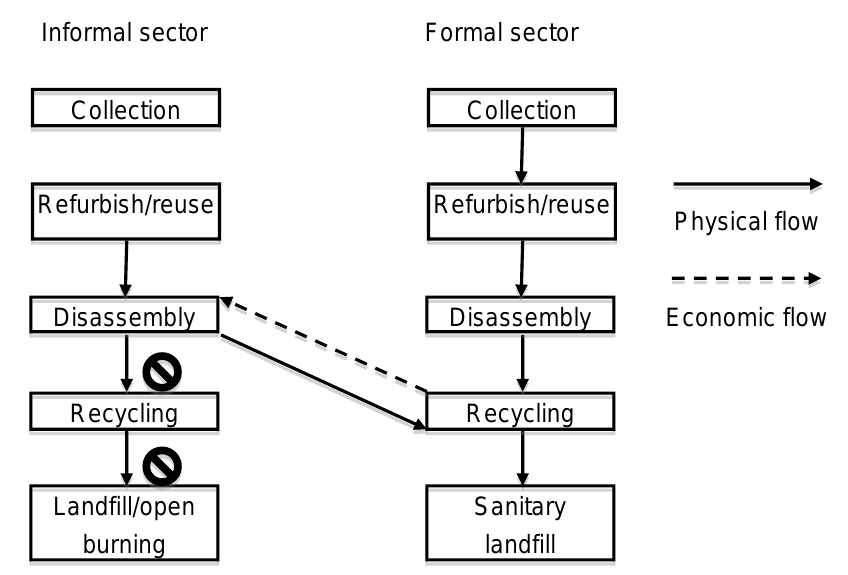
Figure 1. Example of linking informal and formal sectors via an economic